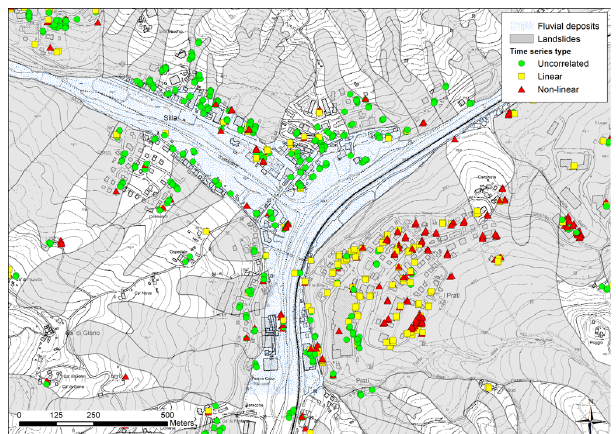
Fig. 12. Classification of PSI time series in the area of Silla (Bologna province, northern Apennines of